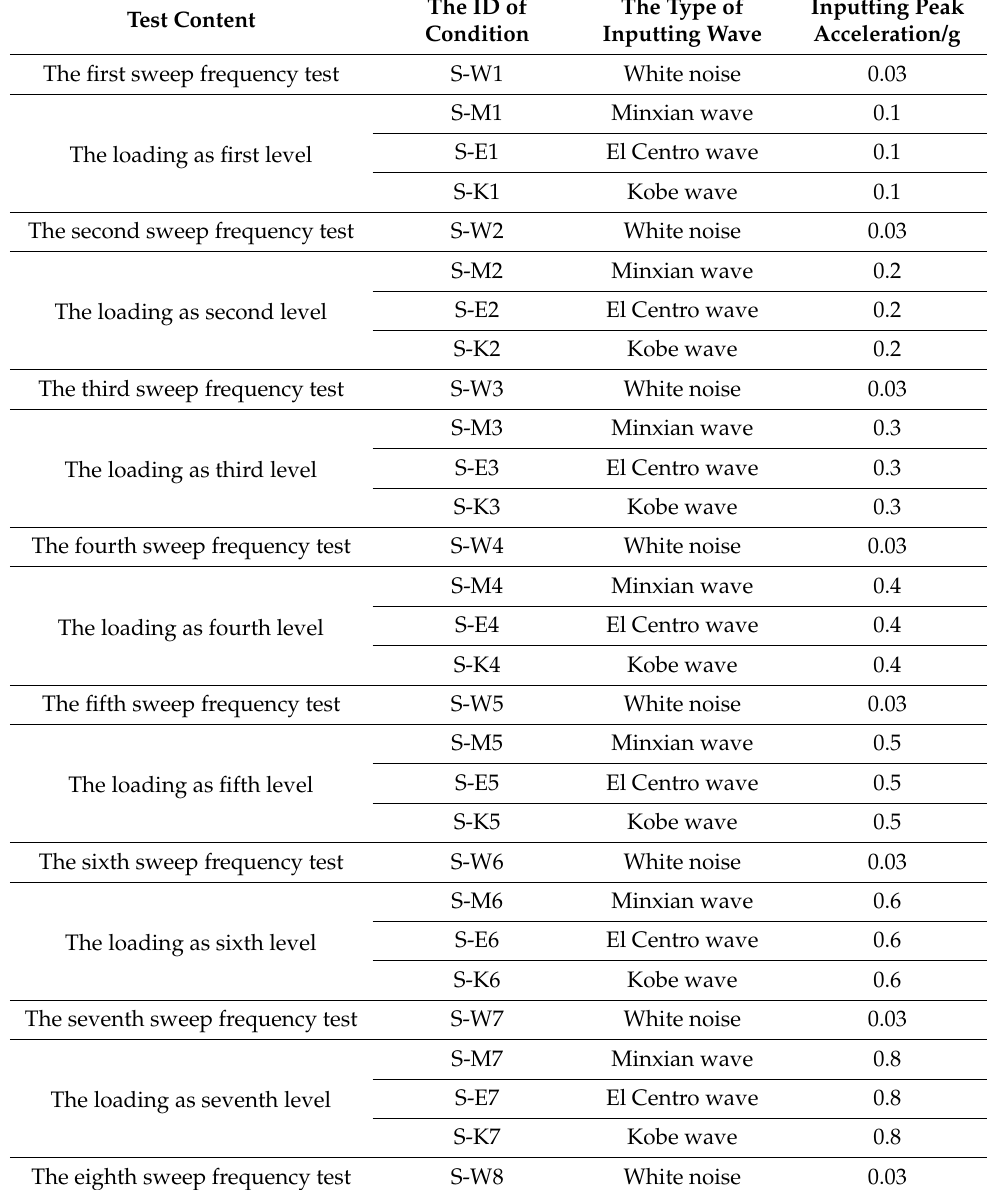
Table 5. Loading sequence of three types of input earthquake